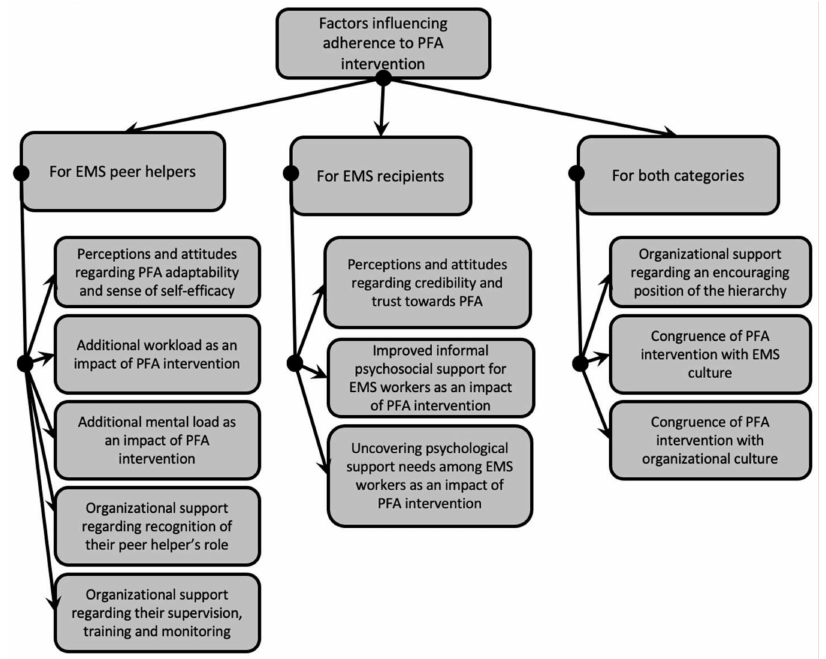
Figure 2. Themes and subthemes graded by category of